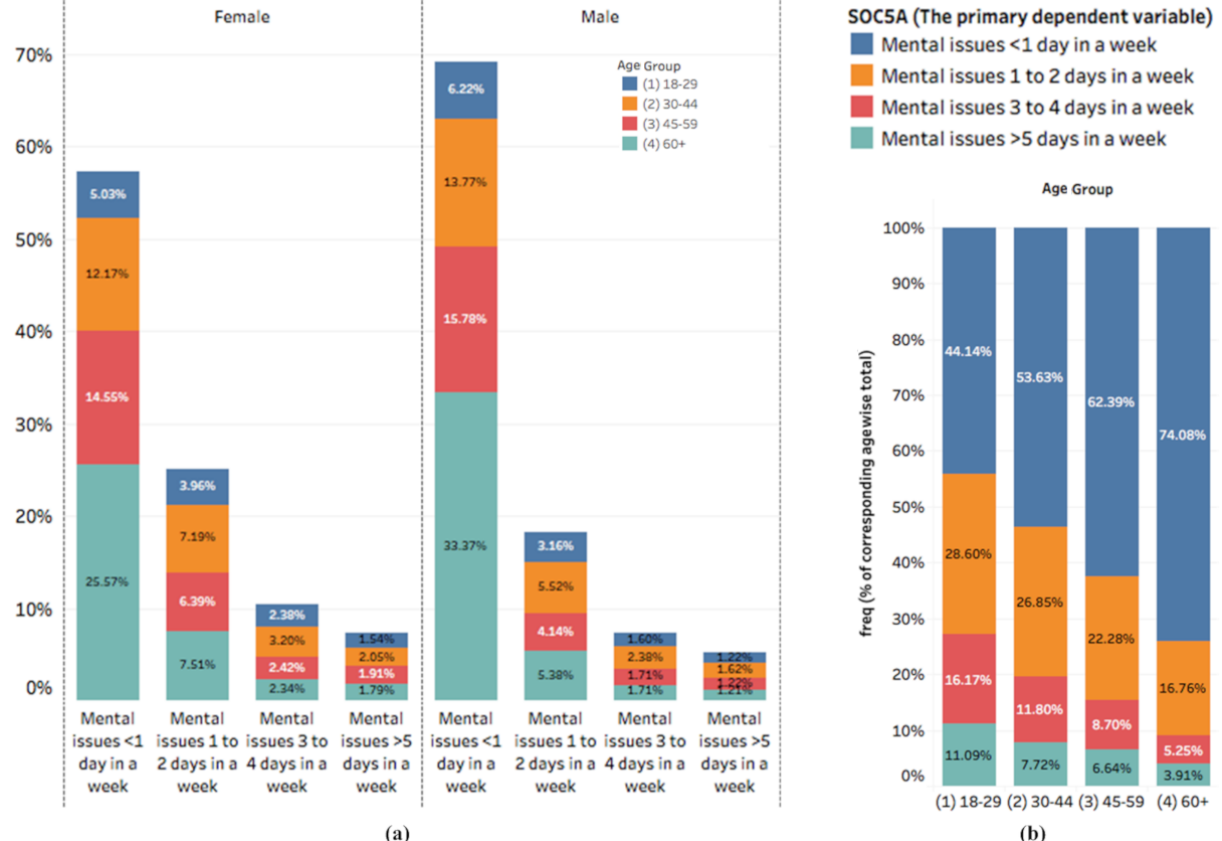
Figure 3. (a) Genderwise and (b) agewise distribution of mental issues (attribute soc5a ) variable. Significance was tested using two proportion z test and chi-square test, respectively, showing a higher prevalence of mental issues among youth and in